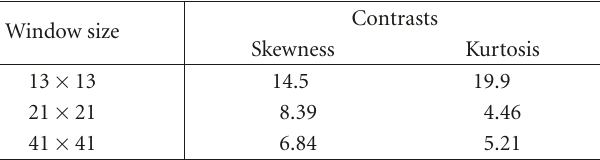
Table 3: Detection performances of the HOS (contrast), with an SNR of 0 dB, in function of the size of the computation window. Window size